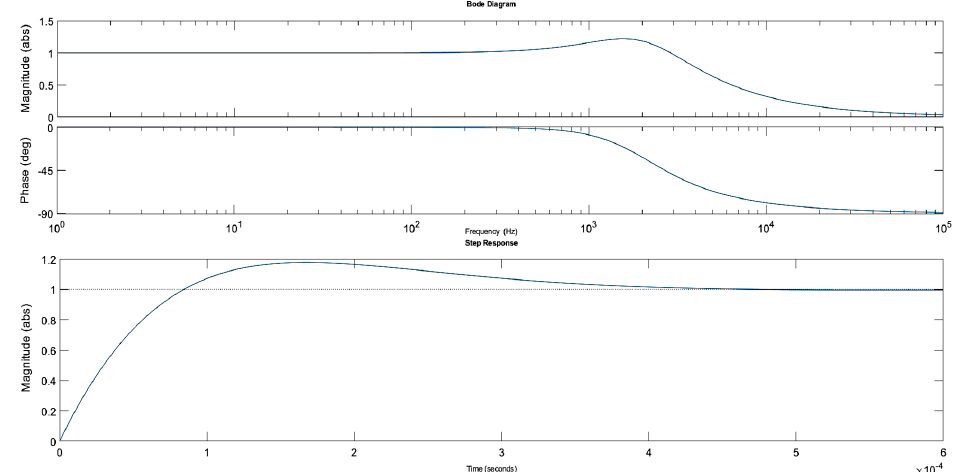
Figure 21. MATLAB simulation results for the circuit response to a lightning impulse with 75 kV peak voltage. The coil inductance is 18.4 H, its resistance is 3.65 k Ω and the parallel resistance is 150 k Ω .